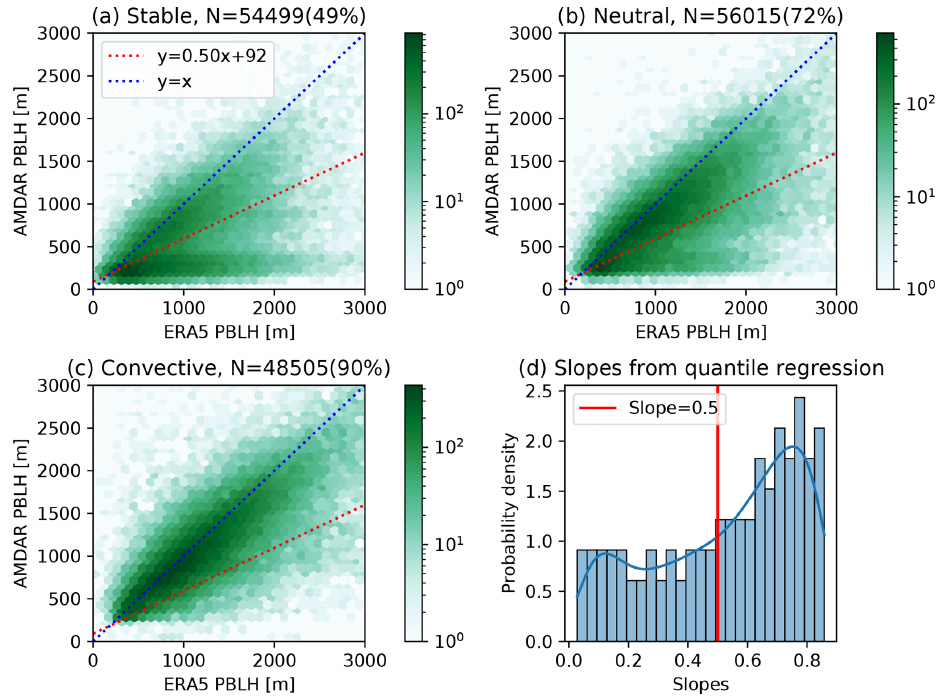
Figure 2. Comparison between PBLHs from AMDAR and ERA5 under stable (a) , neutral (b) , and convective (c) conditions, where atmo- spheric stability is classified using AMDAR profiles following Zhang et al. (2020). The blue and red dashed lines are the 1 : 1 line and the quantile regression line corresponding to a slope of 0 . 5, respectively. The titles give the total number of points as well as the percentage of data points above the 0 . 5-slope line, i.e., the fraction of data after filtering. Panel (d) shows the distribution of quantile regression slopes, where 0 . 5 marks the threshold between two